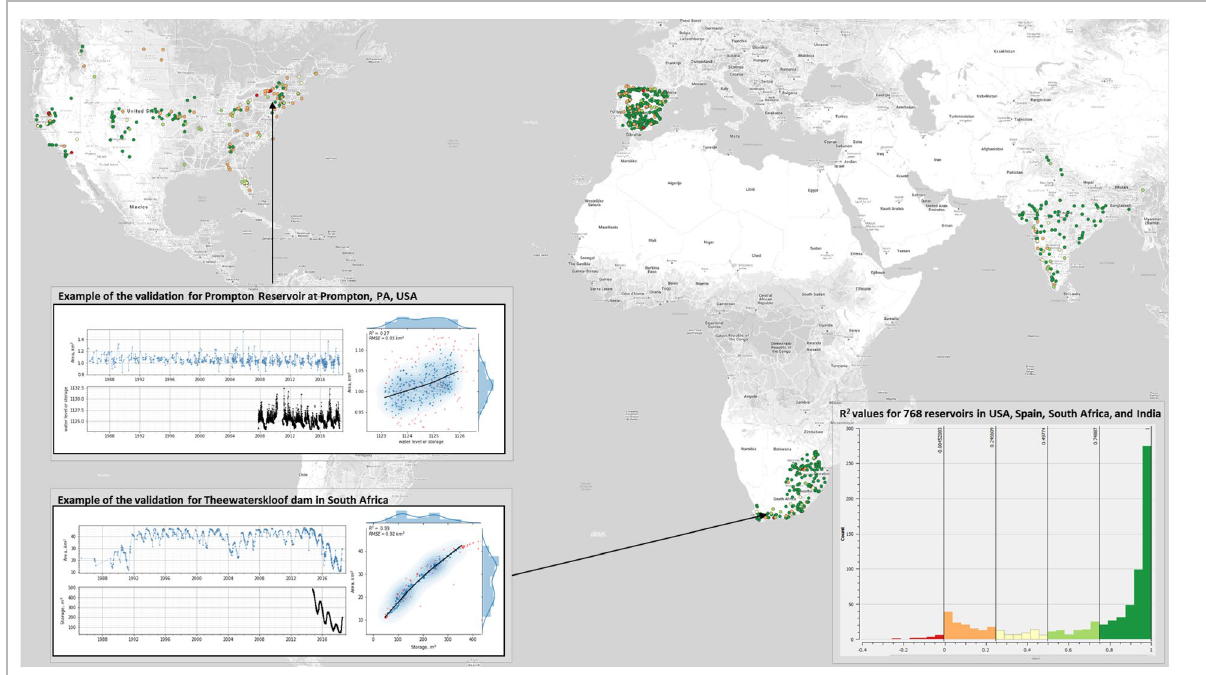
Figure 7. Results of the validation of the reservoir surface water area dataset using 786 in-situ time series of water level and storage for the USA, Spain, South Africa, and India. Frequency histogram chart (bottom-right) shows the distribution of the coefficient of determination (R 2 ) for all reservoirs used in the validation; charts at the left show examples of the performed validation procedure, with a good fit (bottom, R 2 = 0.99, RMSE = 0.92 km 2 ) for the Theewaterskloof reservoir in South Africa, Mediterranean climate zone and less good (top, R 2 = 0.27, RMSE = 0.03 km 2 ) for the small Prompton Reservoir in the USA located in humid continental climate zone. The figure was generated using Google Earth Engine Code Editor 14 and the charts were generated with Matplotlib 34 and Seaborn 68 libraries. Code: https:// code. earth engine. google. com/ 29230 bfe29 78625 f0981 890b1 565c6